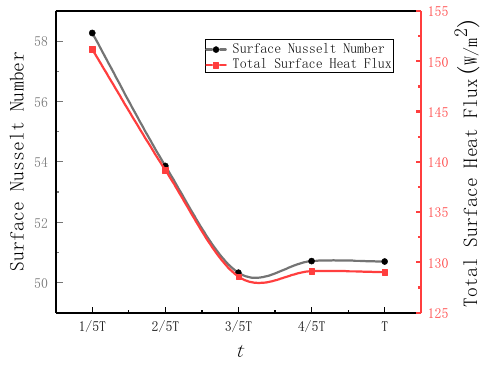
Figure 8. The curve of Nu and φ on the heat exchange wall with time.